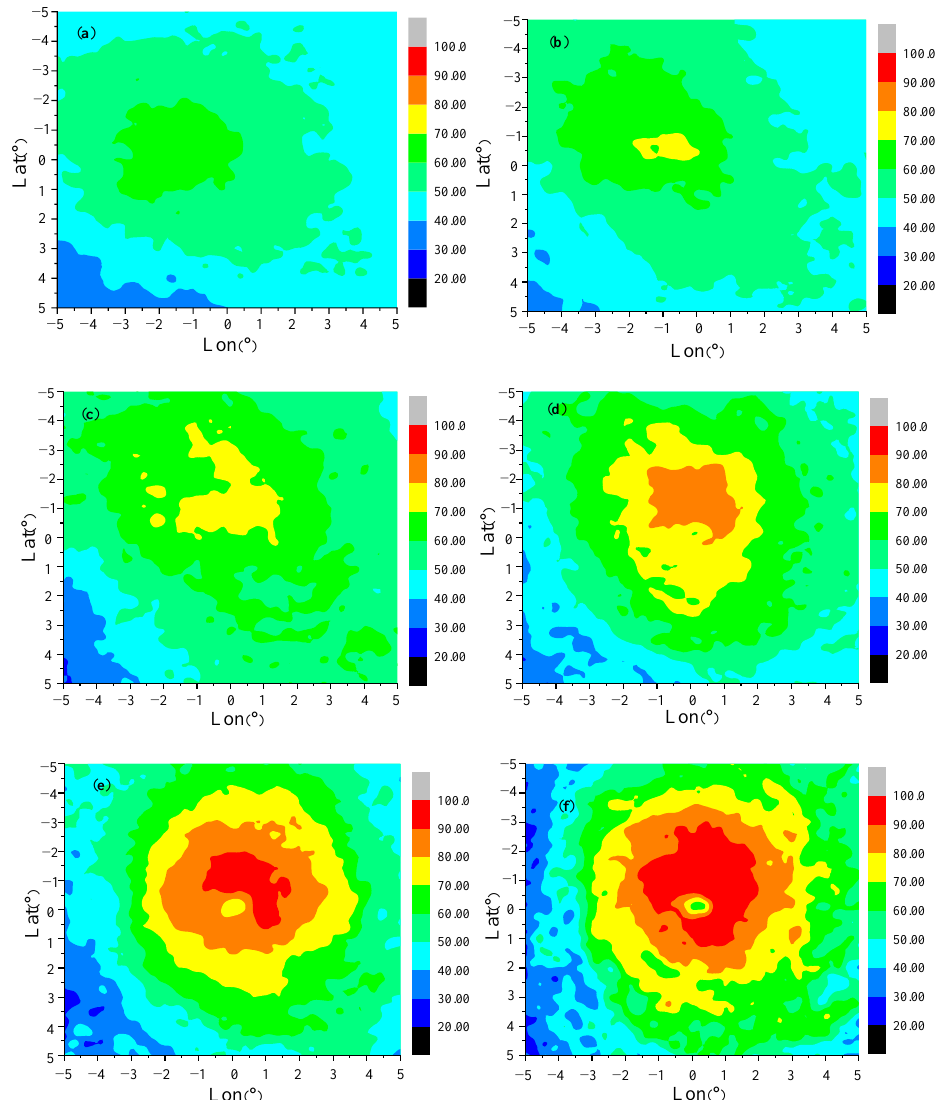
Figure 6. Spatial distribution of ice cloud fraction (%) in different TC intensity: ( a ) TD, ( b ) TS, ( c ) STS, ( d ) TY, ( e ) STY, and ( f ) Super TY.